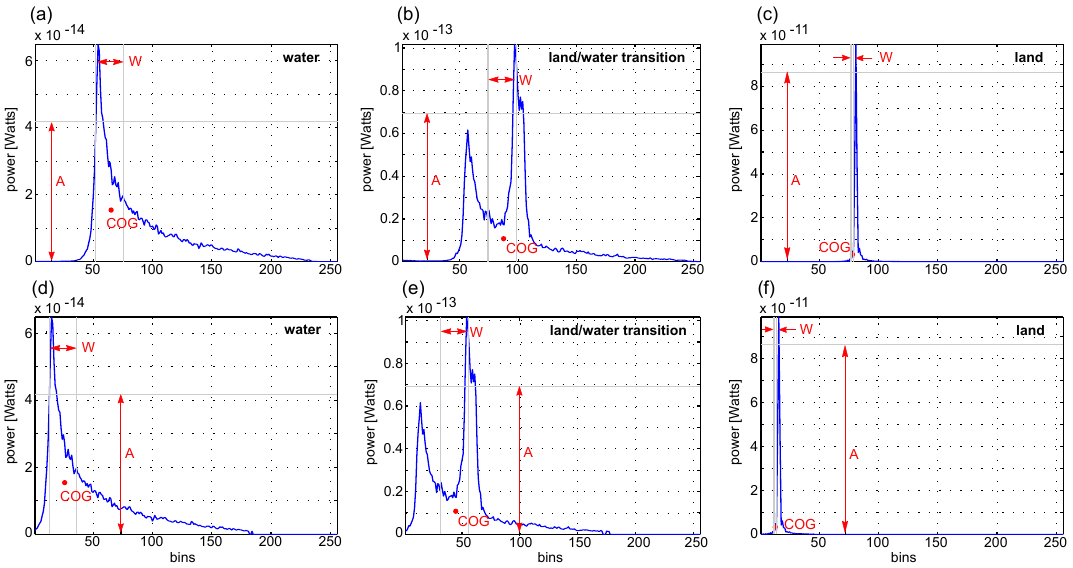
Figure 1. Offset Center Of Gravity (OCOG) parameters for the three classes: water, land-water transition and land are shown for the original waveforms ( a – c ) and the shifted waveforms ( d – f